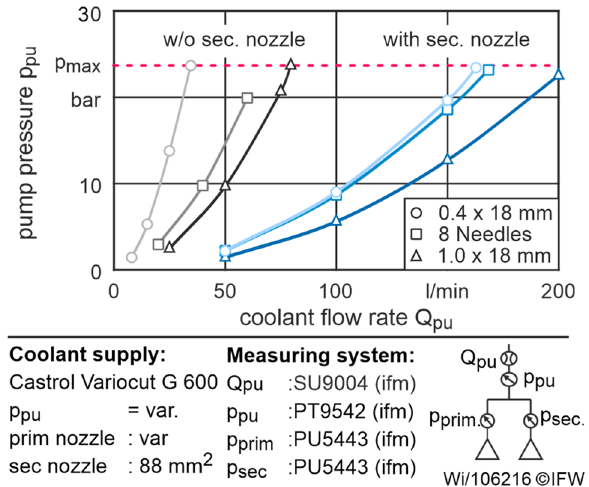
Fig. 7 Pump pressure and resulting flow rates for different primary nozzles with and without the secondary